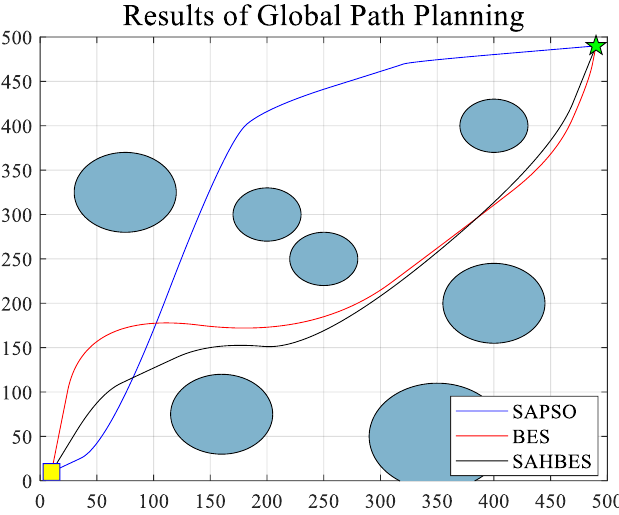
Figure 7. Global path planning chart of random obstacles simulation.